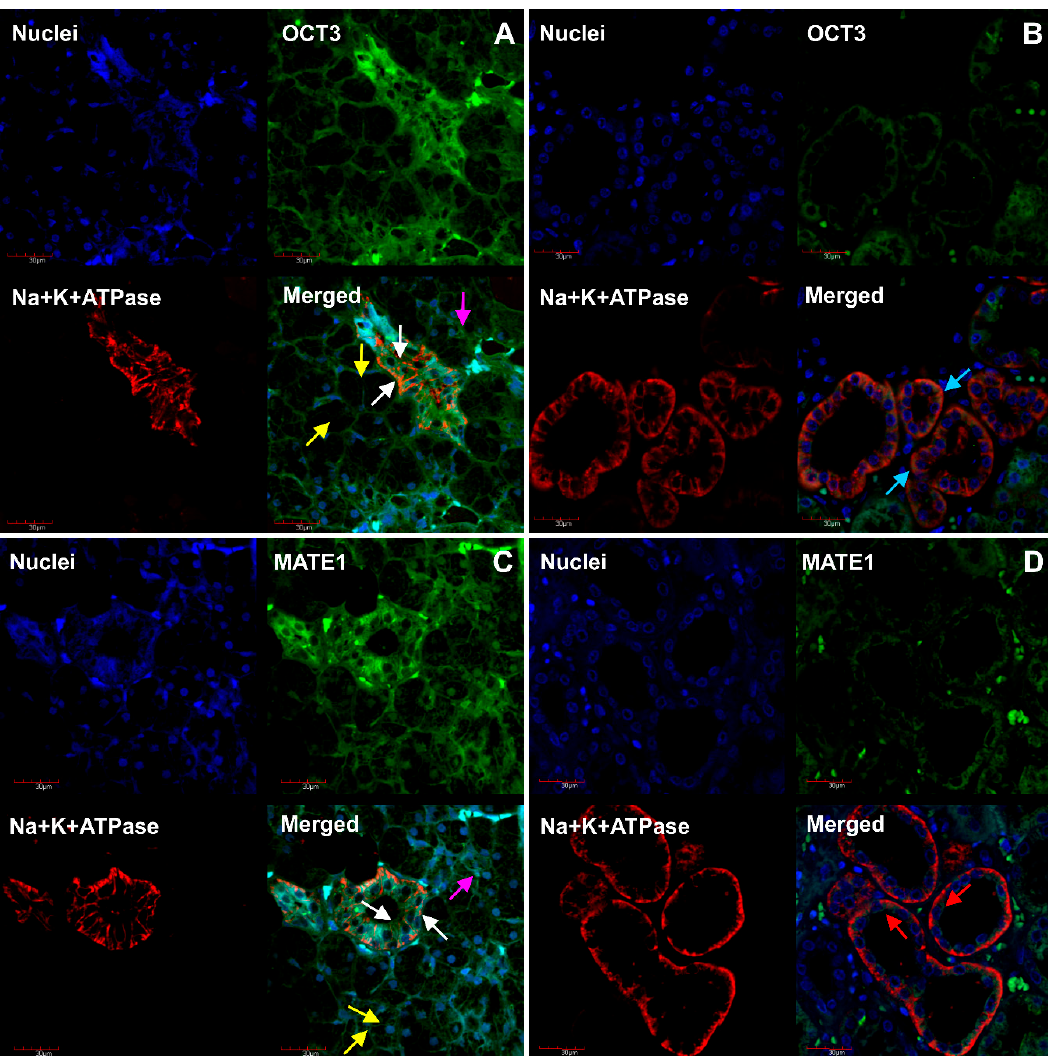
Figure 3. Immunofluorescence staining of OCT3 and MATE1 in salivary glands and kidney cortex. ( A ) OCT3 (green panel) expression at the basolateral and apical membrane of serous and mucous acinar cells and in duct cells. ( B ) OCT3 (green panel) expression at basolateral membrane of kidney proximal tubule. ( C ) MATE1 (green panel) detection at the basolateral and apical membrane of serous and mucous acinar cells and in duct cells. ( D ) MATE1 (green panel) detection at apical membrane of kidney proximal tubule. Na + /K + -ATPase (red panel A – D ) was used as the basolateral membrane marker. Nuclei are stained blue ( A – D ). Yellow arrow—apical and basolateral membrane of mucous acinar cells; white arrow—apical and basolateral membrane of duct cells; pink arrow—serous acinar cells; blue and red arrow—basolateral and apical membrane of proximal tubule cells, respectively.